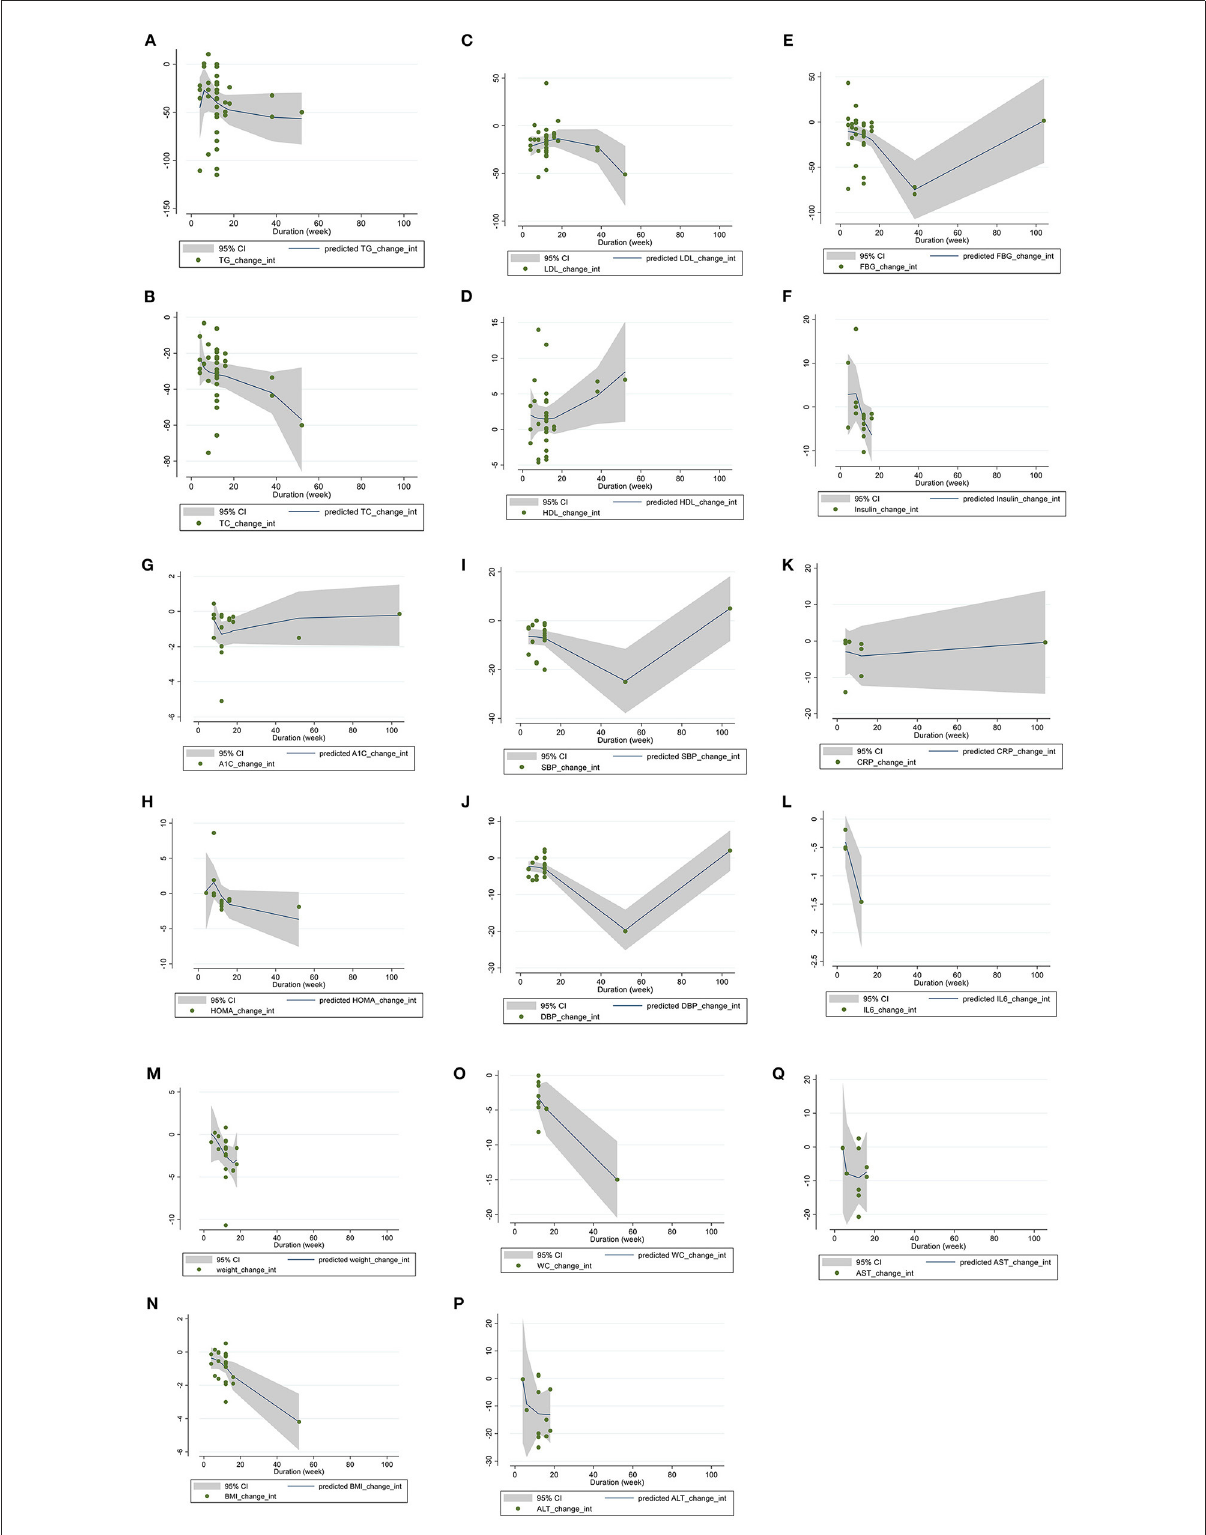
FIGURE7 Non-linear dose-response relations between berberine consumption and absolute mean differences. Dose-response relations between duration of intervention (week) and absolute mean differences in (A) TG (mg/dl); (B) TC (mg/dl); (C) LDL (mg/dl); (D) HDL (mg/dl); (E)